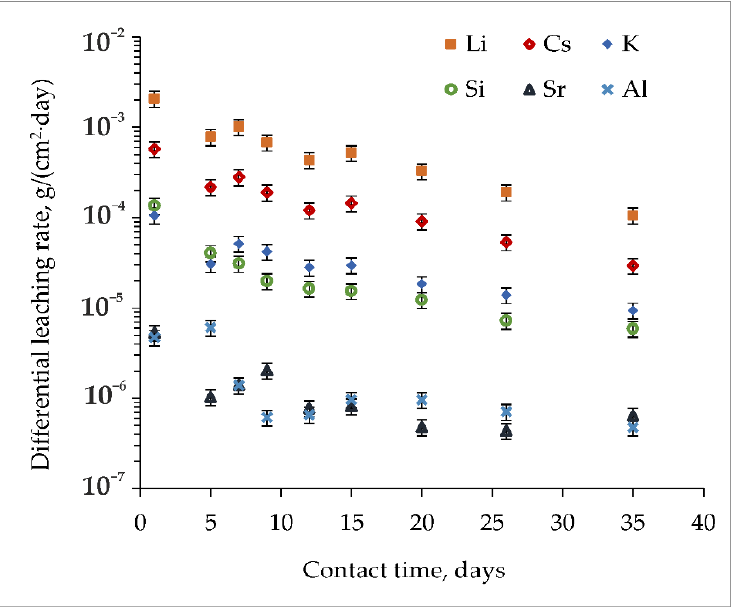
Figure 9. Kinetic curve of the leaching rate of components of the ceramics based on bentonite clay.